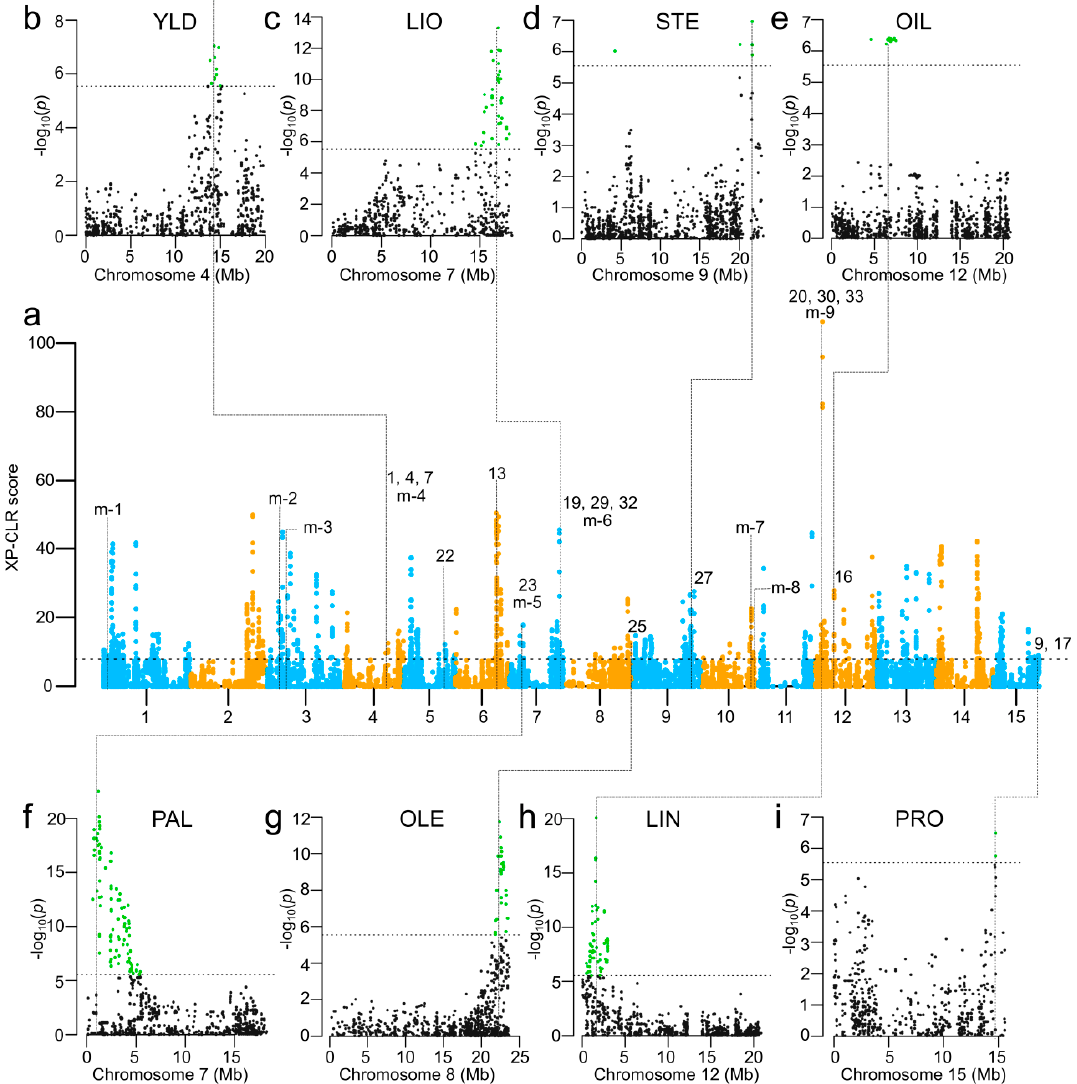
Figure 7. Genome-wide selective sweep scan using XP-CLR between BM and EV ( a ), and Manhattan plots of QTL overlapping with selective sweeps for ( b ) seed yield (YLD), ( c ) linoleic acid content (LIO), ( d ) steric acid content (STE), ( e ) oil content (OIL), ( f ) palmitic acid content (PAL), ( g ) oleic acid content (OLE), ( h ) linolenic acid content (LIN), and ( i ) protein content (PRO). QTL associated with selective sweeps are also labeled on peaks of selective sweeps. The numbers represent the QTL numbers listed in Table 3. Multiple numbers on the same peak represent genomic regions co-located with more than one trait. The labels ‘m-#’ represent the genomic regions associated with QTL previously identified and listed in Table S11. The green dots on Manhattan plots represent significant SNPs.